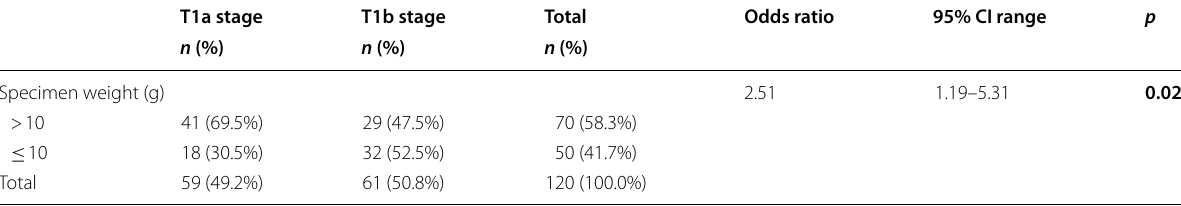
CI Confidence interval Bold values indicate statistical significance at the p < 0.05